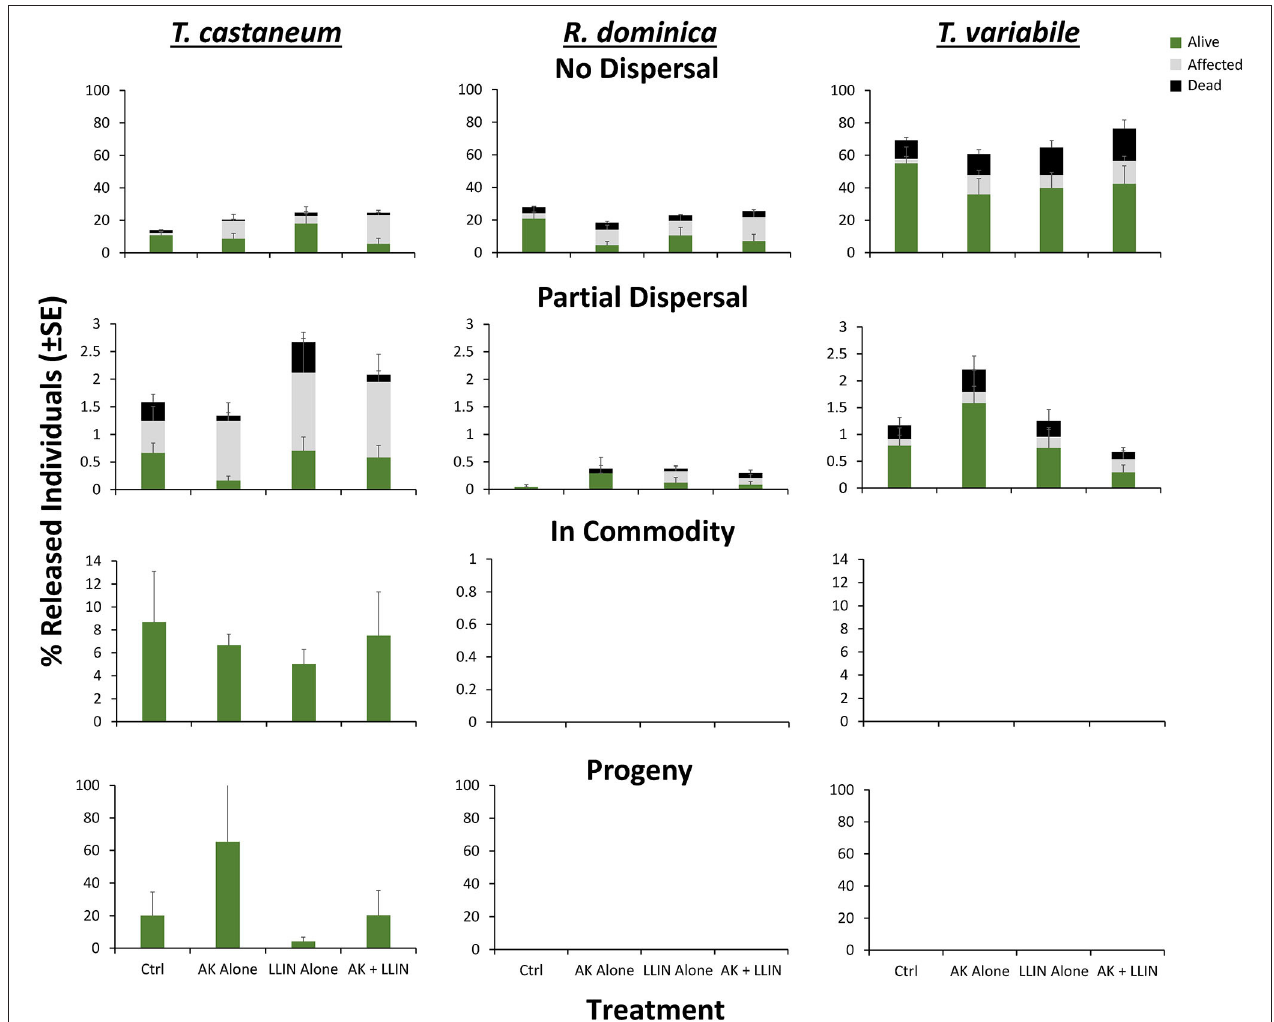
FIGURE 12 | Mean ( ± SE) percentage of 100 T. castaneum (left column), R. dominica (middle), and T. variabile (right) recaptured that were classified as alive (green), affected (gray), or dead (black) after dispersing 72h for Trial 2 in pilot-scale warehouses in Manhattan, KS during 2019 to assess the relative efficacy of LLIN alone (LLIN alone), AK-based interception traps alone (AK alone), both together (AK + LLIN), or neither (Ctrl). Individuals were recorded as not dispersing (Zone 6, top row), partially dispersing (Zones 2–5, second row), infesting the commodity (Zone 1, third row), or producing progeny after a 6-week holding period (bottom row). Bars with shared letters are not significantly different from each other (Tukey HSD, α =